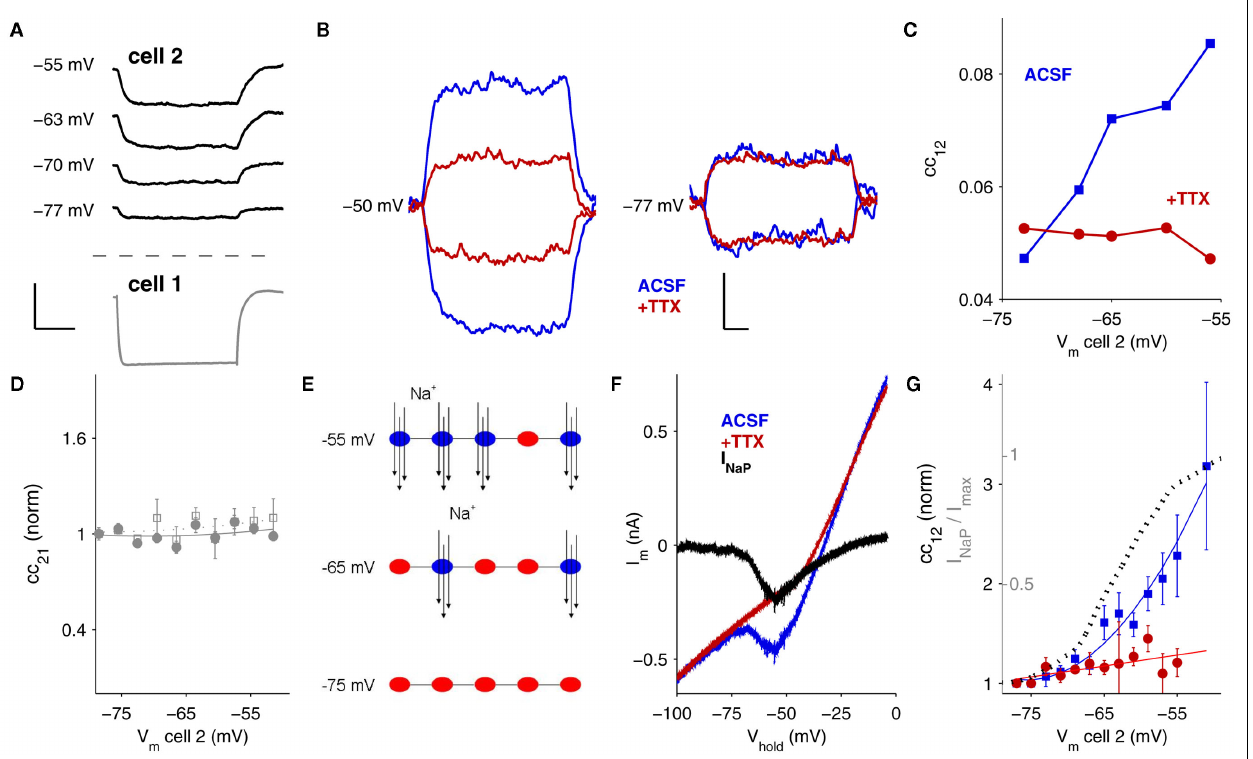
FIGURE 1 | Signals relayed through electrical synapses are amplified by I NaP . (A) Gap junction-relayed responses in cell 2 at different baseline membrane potentials (top) and response to hyperpolarizing current injection in cell 1 (bottom, V m =− 67mV for all trials). Scale bar is 0.2s, 15mV (bottom), 5mV (top). (B) At a baseline of V m =− 50mV (left), both hyperpolarizing and depolarizing responses in cell 2 are amplified by I NaP (blue traces); blockade of I NaP byTTX eliminates the amplification (red traces). At V m =− 77mV (right), I NaP is inactive and does not amplify hyperpolarizing or depolarizing gap junctional responses. Scale bar is 0.1s, 0.5mV. (C) Coupling coefficients measured from cell 1 to cell 2 (cc 12 = Δ V cell2 / Δ V cell1 ) plotted against the baseline voltage of cell 2, for a single pair. Blue data were recorded in control ACSF; red data in 100nMTTX. (D) Coupling coefficients (filled circles) and conductance (open squares) measured from cell 2 to cell 1 (cc 21 = Δ V cell1 / Δ V cell2 ) as cell 2 is